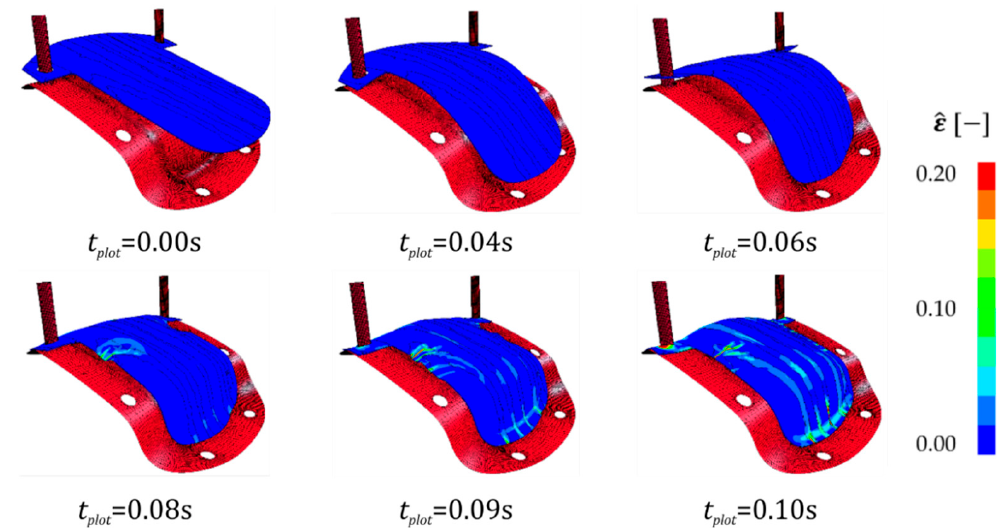
Figure 8. Development of deformations of sample 1 over the time of the closing process of the punch in the simulation.